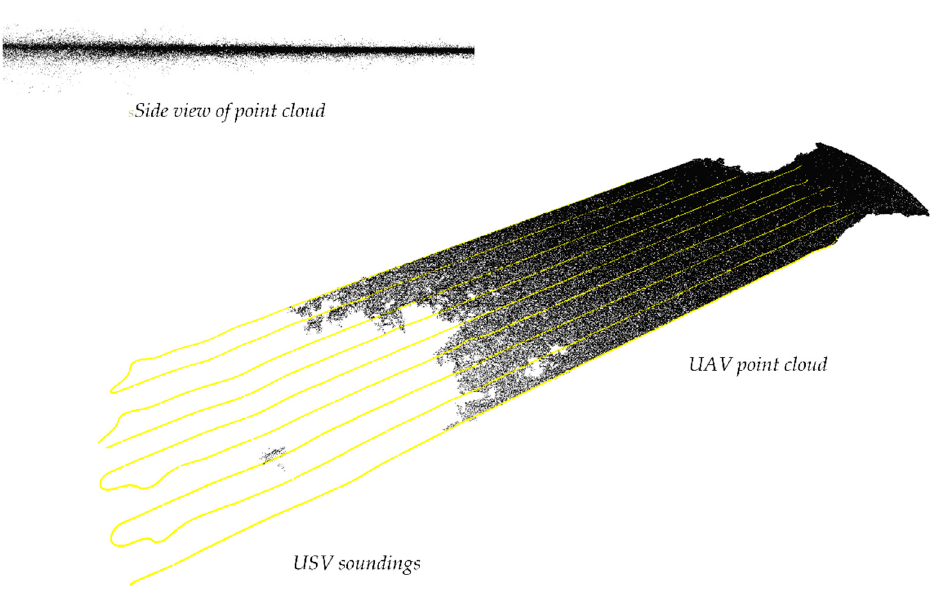
Figure 8. 3D view of a UAV point cloud (black) and USV soundings (yellow).